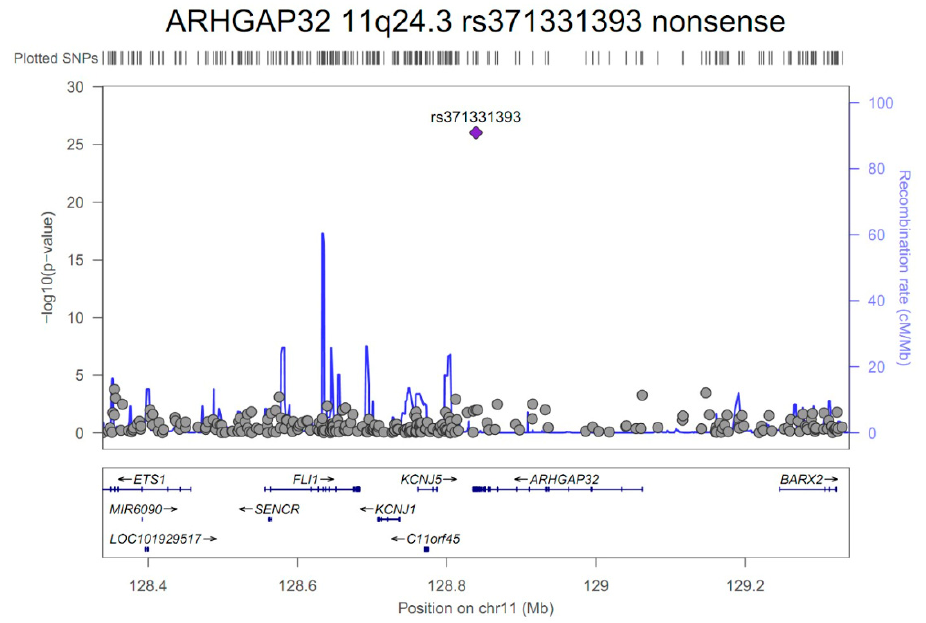
Figure 2. A regional plot of the rs371331393 (stop-gained mutation, ARHGAP32 , 11q24.3) variant’s position ± 500 kb shows associations with intracranial aneurysms in 250 patients and 294 controls after adjusting for age, sex, hypertension, diabetes, hyperlipidemia, cigarette smoking, and four principal components. The x- and y-axes indicate the chromosomal position (mega base, Mb) and -log 10 transformed P -values, respectively. The purple diamond indicates the rs371331393 variant demonstrating the most significant association in our genome-wide association study ( P = 9.3 × 10 − 27 ). The gray circles indicate other SNPs within 500 kb of the rs371331393 variant’s position.